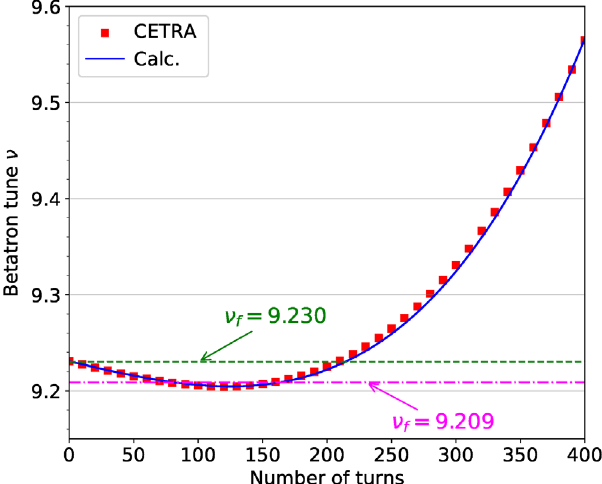
FIG. 1. Vertical betatron tune as a function of the number of turns after the rf is turned off. Red squares represent the CETRA calculation, while a blue solid curve represents the fit to the CETRA results with Eq. (12). Green dashed and magenta dash- dotted lines correspond to shaker ’ s tune (frequency) ν f ¼ 9 . 230 and ν f ¼ 9 . 209 , respectively.